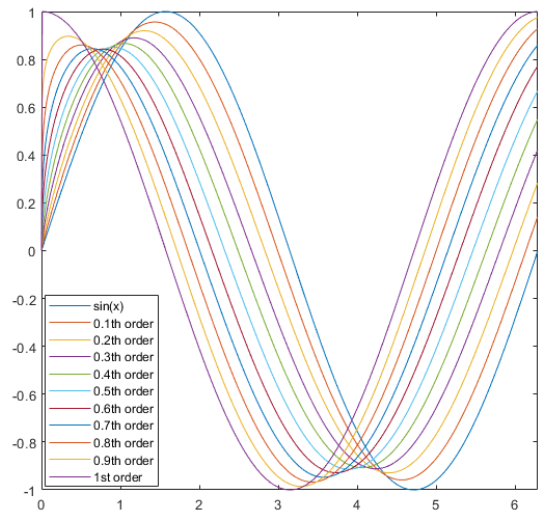
Figure 1. Fractional derivatives of the sine function with order between 0.1 and